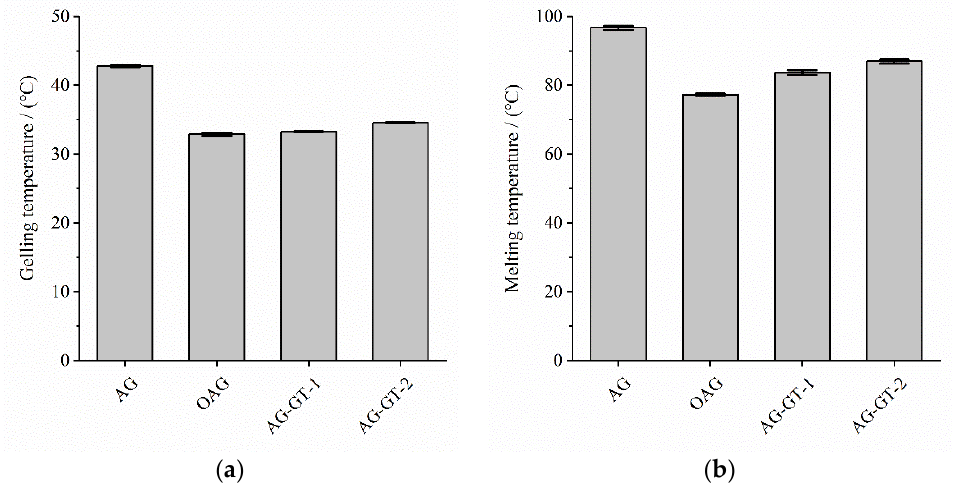
Figure 2. Gelling temperature ( a ) and melting temperature ( b ) for AG and its derivatives.